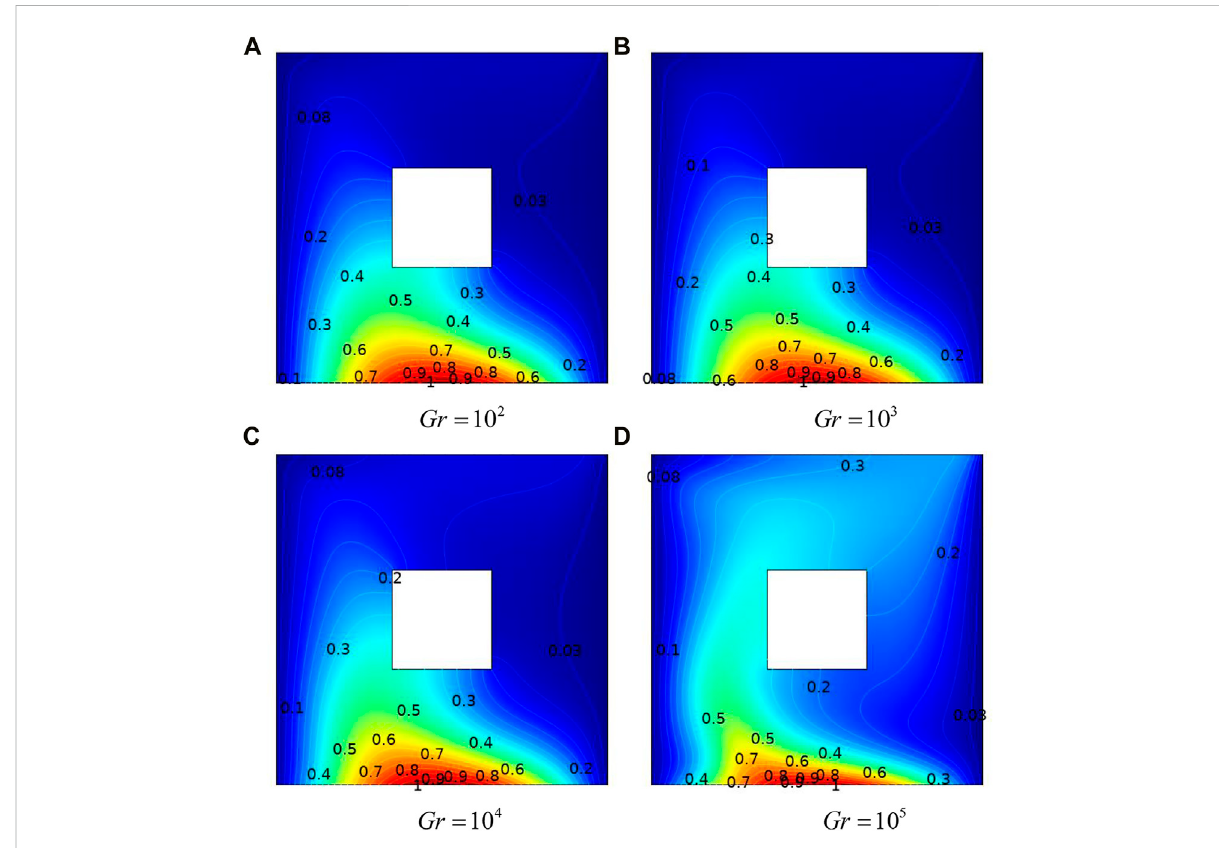
FIGURE 11 In fl uence of Ha on streamlines with a non-uniformly heated bottom wall: adiabatic cylinder with Re (cid:2) 100 and r (cid:2) 10 4